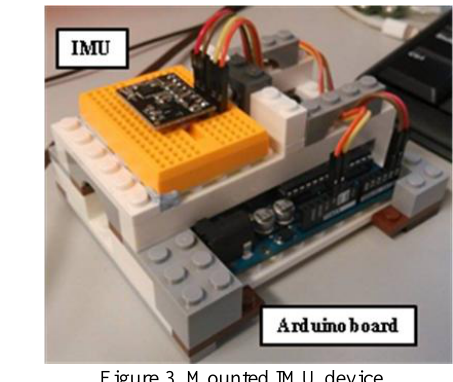
Figure 3. Mounted IMU device.